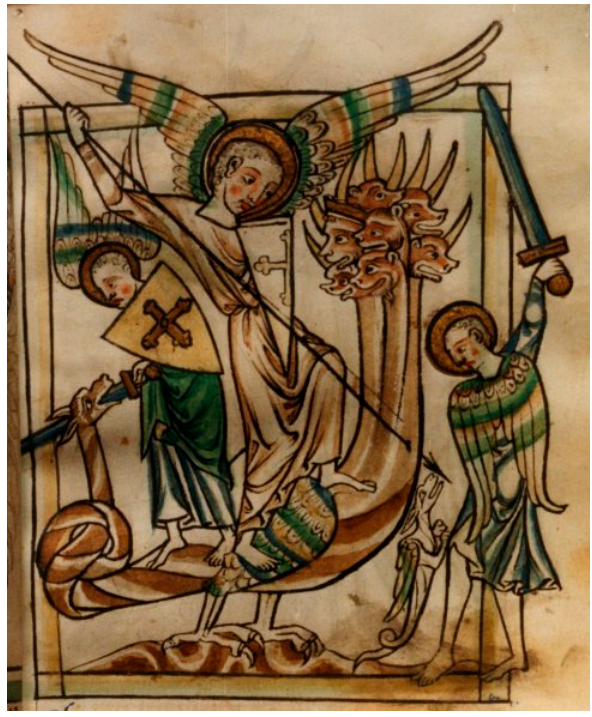
Figure 3. Lambeth 434 (London, Lambeth Palace Library MS 434). Fol. 18 r , c. 1250–60, by permission of Lambeth Palace Library.